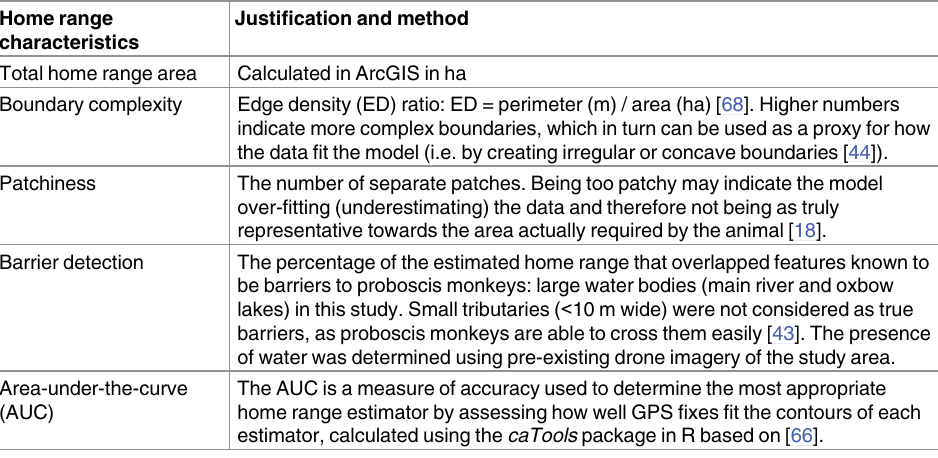
Table 1. Summary and methods used to calculate the physical characteristics used to compare the home range